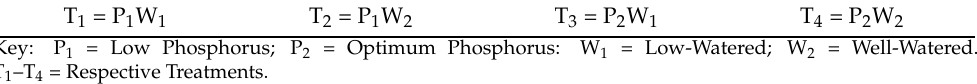
Table 17. Illustration of the factorial